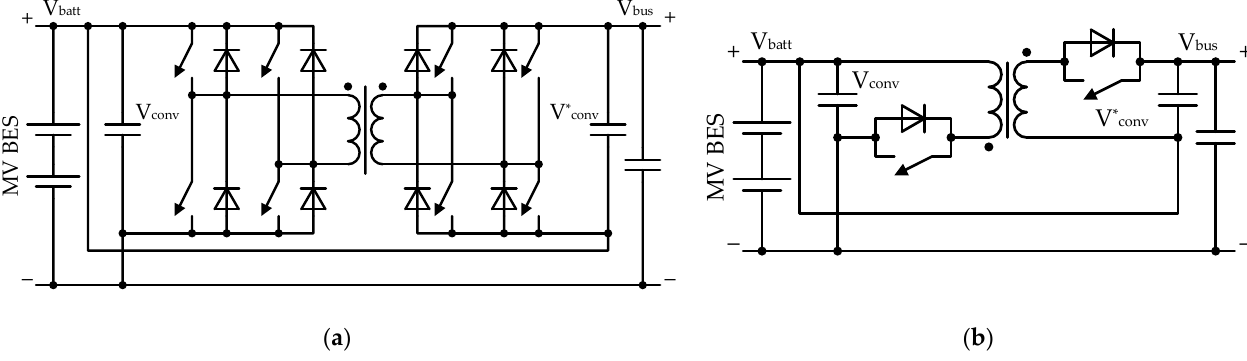
Figure 22. Examples of PPCs: ( a ) parallel input — series output PPC with DAB, ( b ) parallel input — series output PPC with flyback converter.